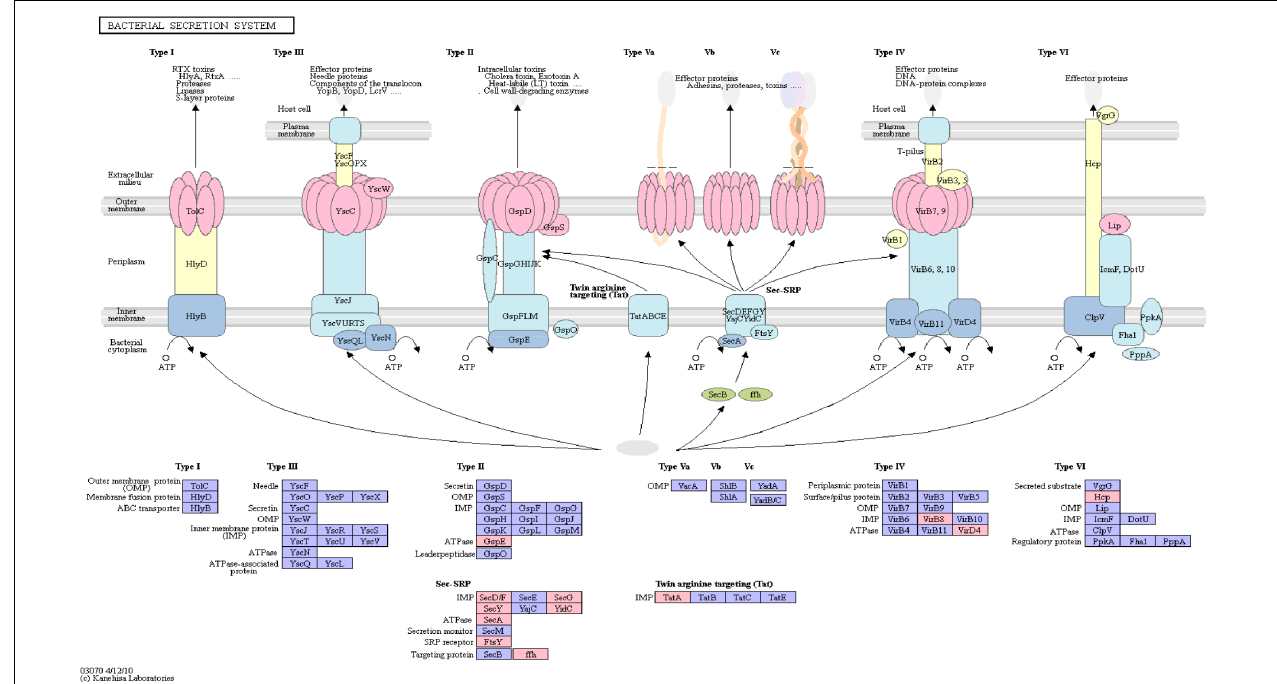
FIGURE 4 | Bacterial Secretion System from KEGG. Proteins encoded by bacterial genome regions that revealed miRNA target matches are colored in pink.